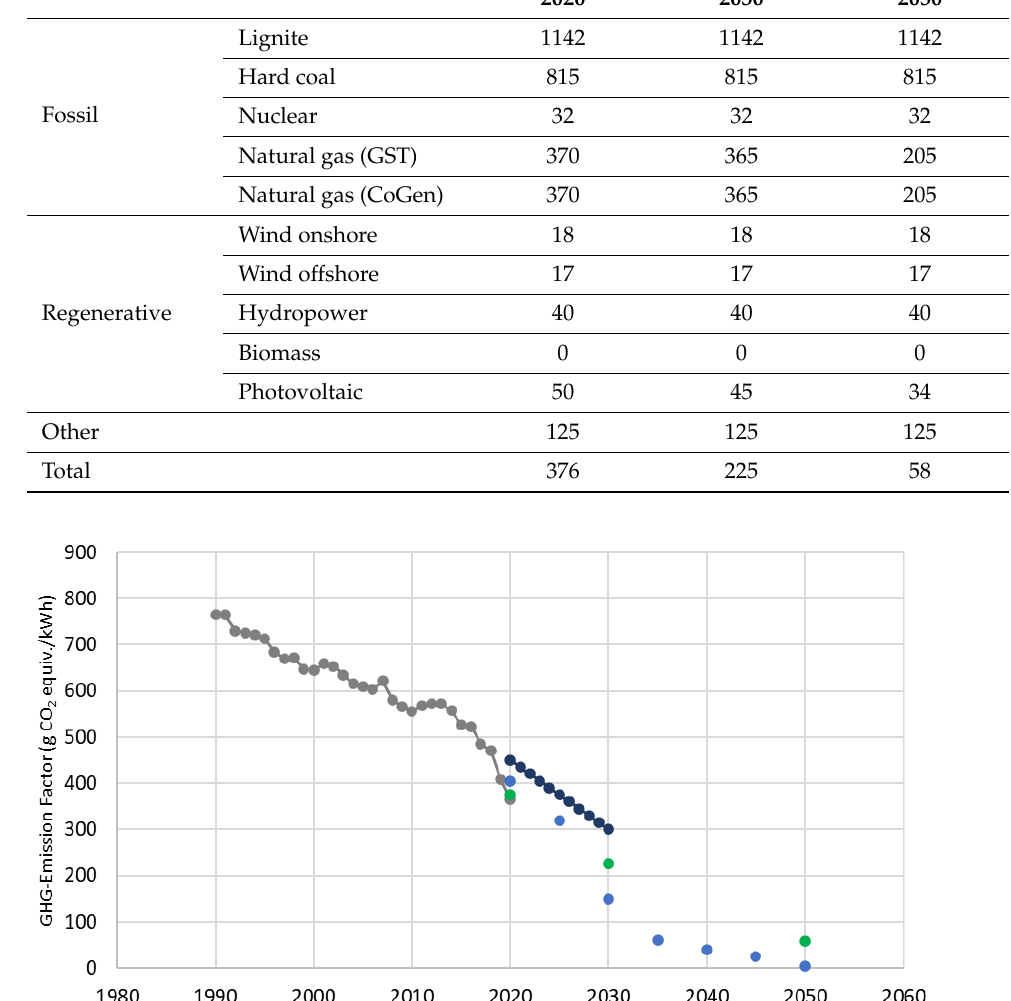
Figure 8. GHG emissions of German electricity generation over time. Grey circles—historical data [63]. Dark blue, light blue, and green circles—predictions from [9,20] and the present work, in this order.